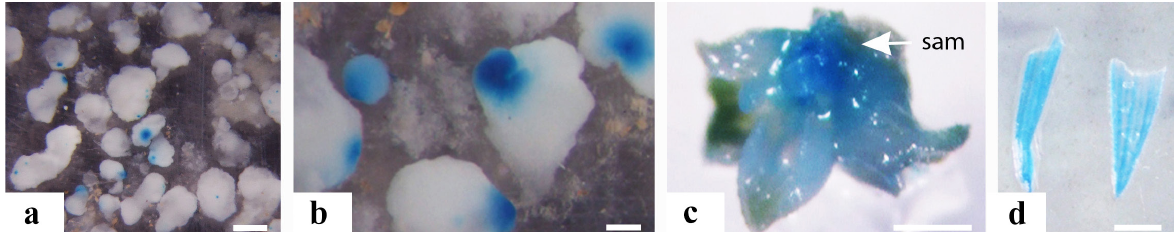
Figure 4 - Cell suspension of Brachiaria brizantha transformed by biolistic. ( a, b ) gus expression after cell suspension bombardment with pAHC27, 24 h after bombardment; ( c ) gus expression in shoot apical meristem; ( d ) leaf fragments expressing gus . sam = shoot apical meristem. Bars: ( a , c , d ) 1 cm; ( b ) 0.2